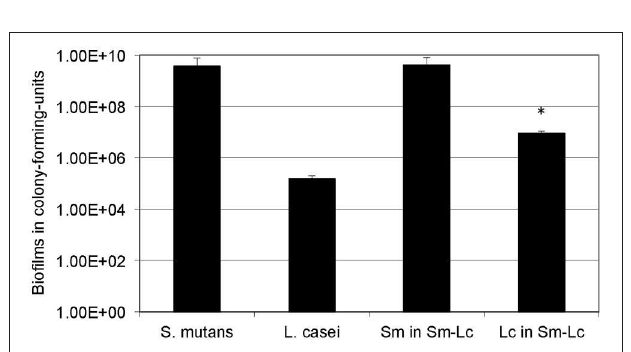
FIGURE 2 | Five-day biofilm grown under continuous flowing conditions. S. mutans (Sm) and L. casei (Lc) mono- and dual-species biofilms were grown on glass slides deposited in a Drip Flow Biofilm Reactor in mFMC containing 18mM glucose and 2mM sucrose. Results represent the average ( ± standard deviation in error bars) of at least three separate experiments, with * indicating statistical difference at P < 0.001 relative to its mono-species biofilms.